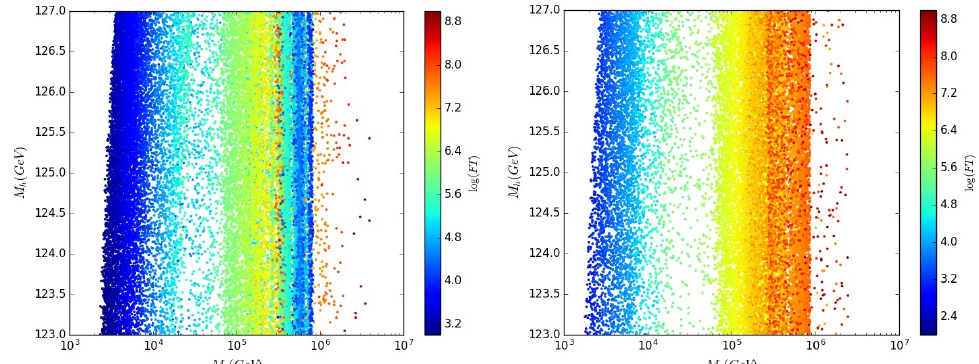
Figure 1. The Kahler deflection and superpotential deflections in AMSB, which can be seen as constrained limits of our EOGM extension of AMSB with multi-scale messengers, can both easily accommodate the 125 GeV Higgs. The upper pannels, with the same setting as our previous work [29], show the predicted Higgs mass